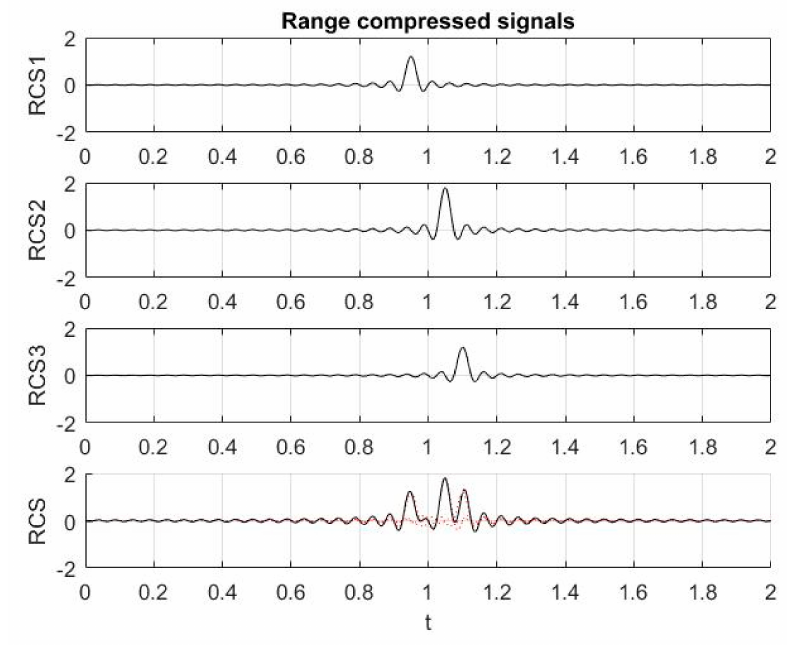
Figure 6. Three range compressed signals RCS1, RCS2, RCS3 and their sum